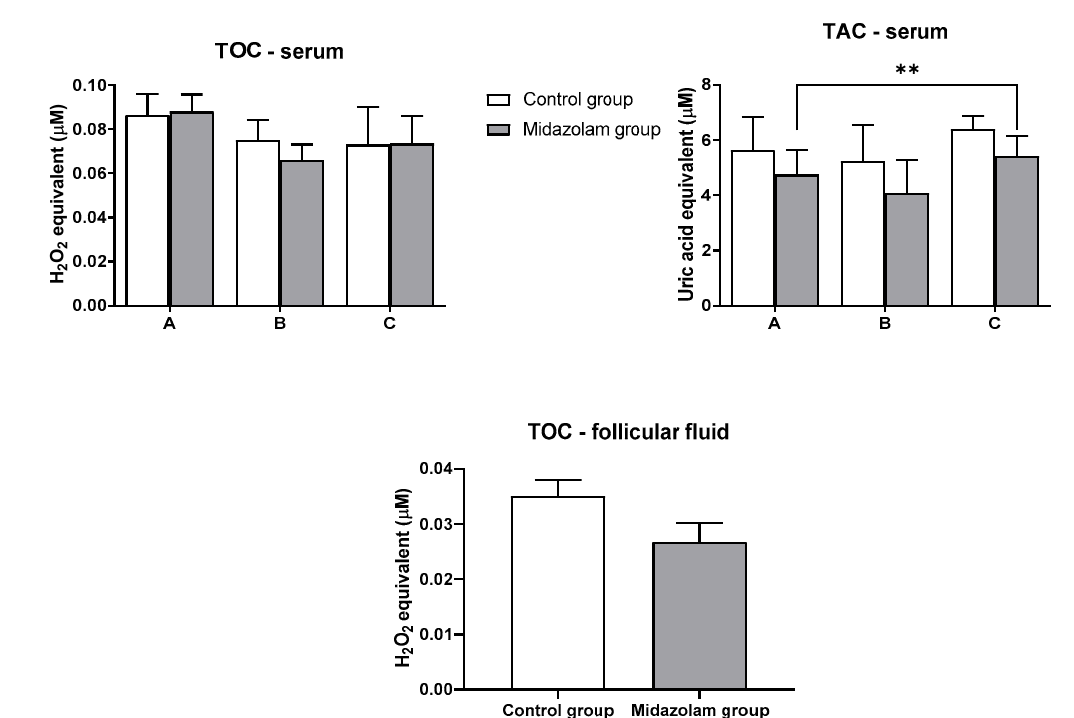
Figure 1. Oxidant and antioxidant capacities in blood serum and follicular fluid. Blood samples of each patient were collected at the acceptance to hospital (time point A), prior to oocyte retrieval (time point B), and 2 h after the procedure (time point C). Values represent mean ± SE; ** p < 0.01. TOC, total oxidant capacity; TAC, total antioxidant capacity.